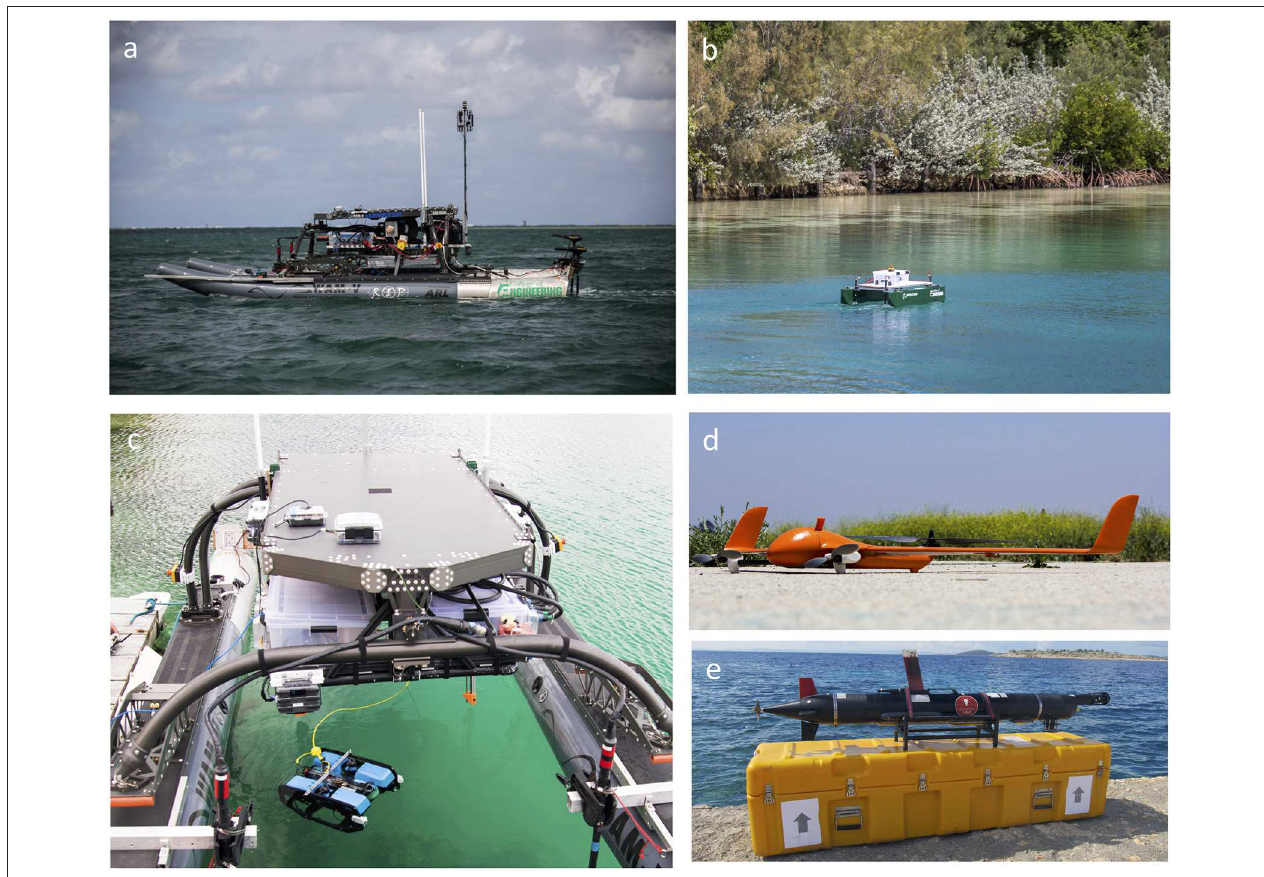
FIGURE 4 | Autonomous Surface Vehicles (ASV’s) can range from commercial products (a) (Marine Advanced Research Inc’s Wave Adaptive Modular—Vessel (WAM-V), to custom built platforms (b) (UH Manoa Engineering “Mr. UH”). (c) Blue Robotic ROV tethered to the WAM-V extends the range of ROV capabilities. Unmanned Aerial Systems (UAS) such as the Flightwave Edge (d) have collected aerial data on open ocean currents, coral reefs, and marine debris. Autonomous Underwater Vehicles (AUVs) such as the LAUV (e) designed by The Faculdada de Engenharia de Universidade do Porto can collect environmental and physical data in open ocean and shallow water